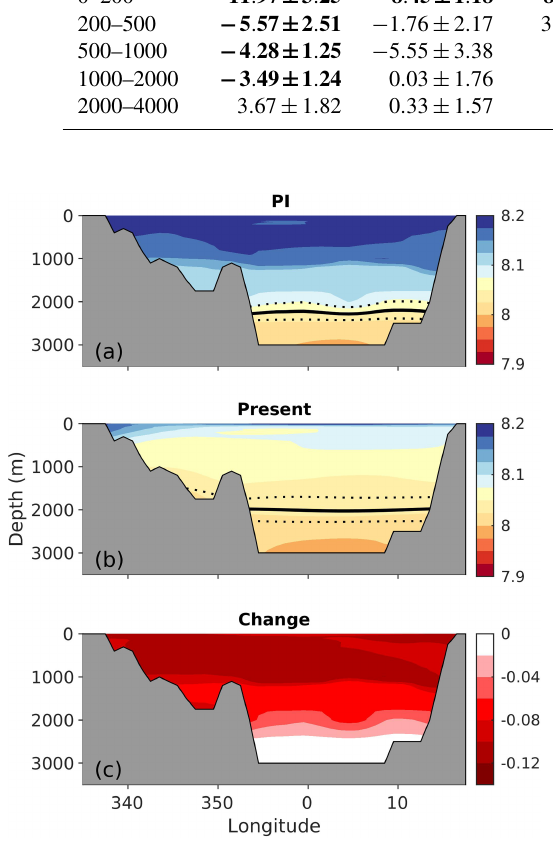
Figure 6. Zonal cross sections (at 70 ◦ N) of the preindustrial (1850– 1859) and the present (1996–2005) pH and the change between the two periods. Note that the simulated increase in atmospheric CO 2 of NorESM1-ME is 13% higher than the observed record between 1850 and 2005, resulting in a simulated decrease in surface pH that is approximately 0.01 too strong (see Sect. 3.3). The solid black line shows the saturation horizon of aragonite ( (cid:127) Ar = 1). The dashed lines show the associated uncertainties ( σ field